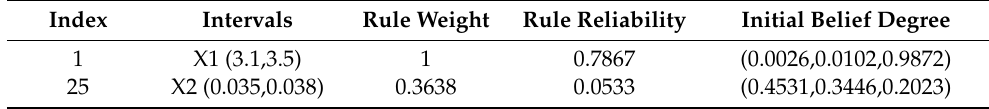
Table A3. The rule weight, rule reliability and belief degree of the proposed model after training.